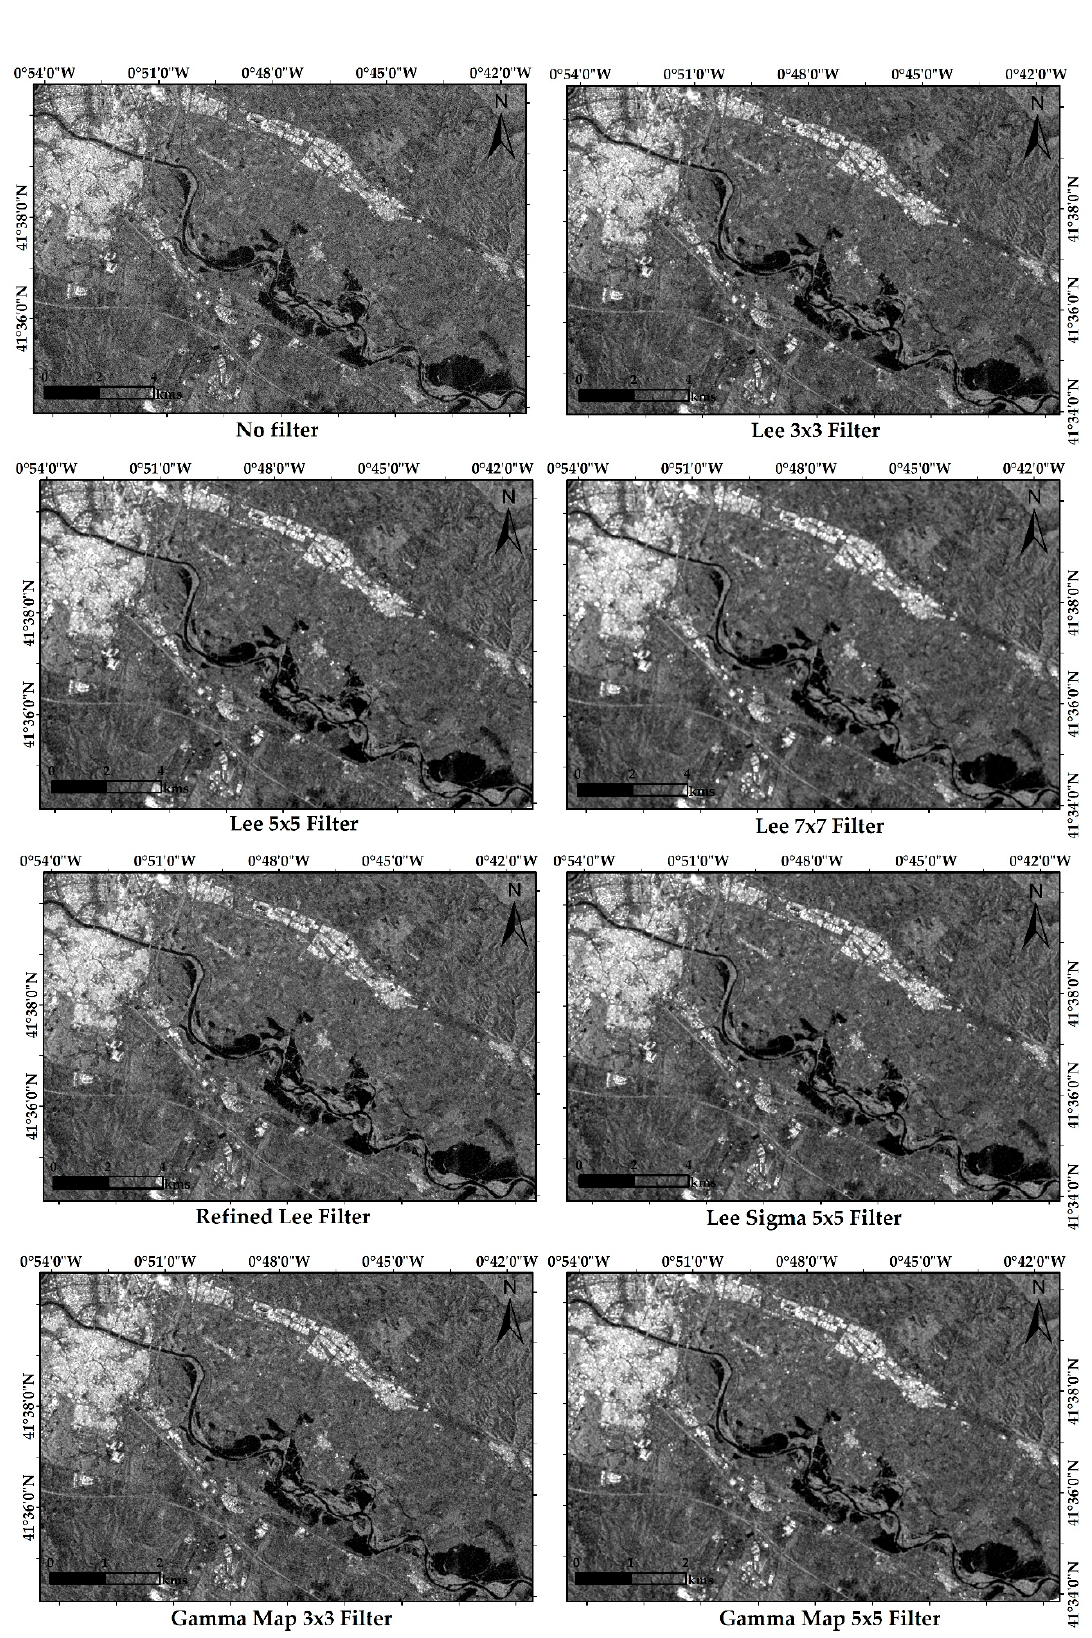
Figure 5. Detailed images of a section of zone 3 (Zaragoza–El Burgo de Ebro), 13 April 2018, after the flood event, with VH polarization in which the comparison is shown between the unfiltered image and the result of the application of different filters of different window sizes.